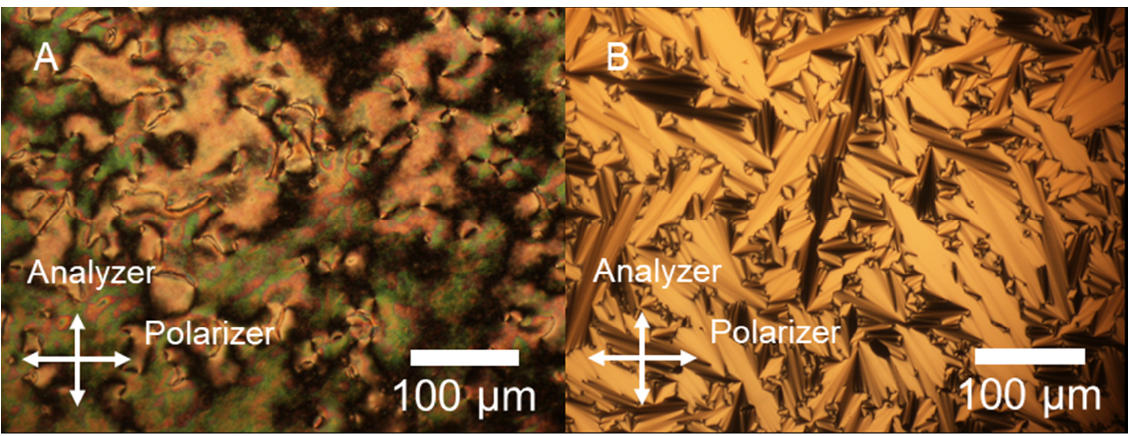
Figure 2. Polarized optical microscopy (POM) images of Schlieren texture of nematic liquid crystal LC ( A ) and fan-shaped texture of smectic LC ( B ).